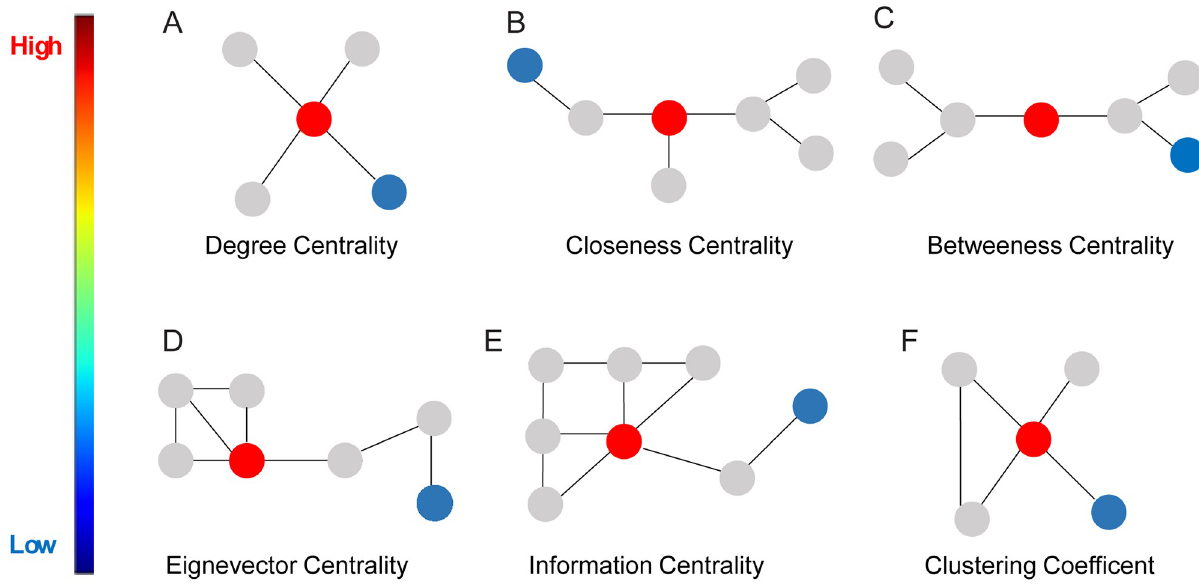
Fig 2. Local SINs measures. Visual representation of differences between local network-based measures in terms of the node centrality. Red colored nodes are nodes with the highest value of the centrality measure, while blue colored are nodes with lower values of the centrality measure. This property varies and depends on the chosen centrality network measure. A) Degree centrality or number of individual interactions (links) with other flies (nodes) in the network. B) Closeness centrality measure defines how close a fly (node) is to all other flies (nodes) in the network. C) Betweenness centrality detects the influence of a fly (node) on the flow of information, depicted as a bridge from one part of a network to another. D) Eigenvector centrality measures the influence a fly (node) in a network based to its neighbours. E) Information centrality or average information of all paths originating from a fly (node). F) Clustering coefficient defines how well are neighbouring flies